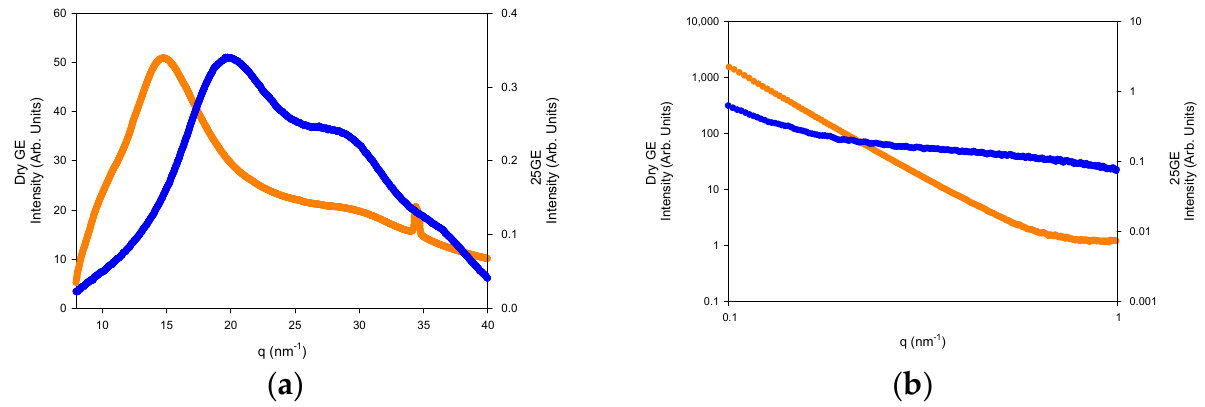
Figure 15. ( a ) WAXS and ( b ) SAXS of Dry GE (Orange line) and 25GE (blue line) at 5 °C·min − 1 at 25 °C.